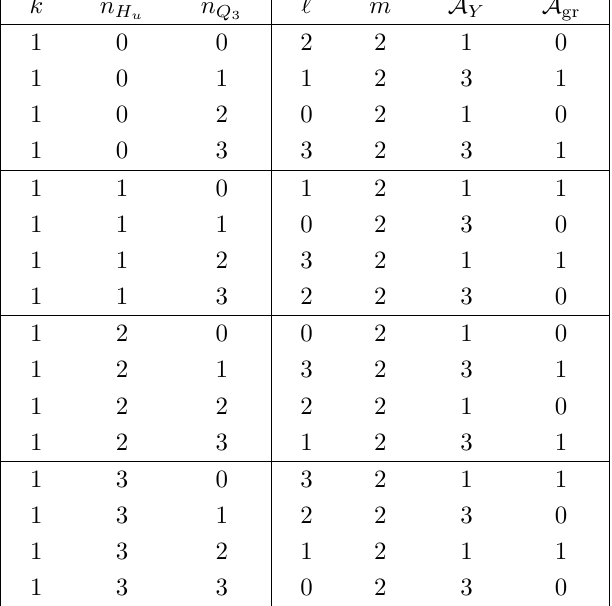
Table 2 . The same (cid:12)gure as table 1, but k = 1 ( m = 2). If n Y is a multiple of 4, the anomalies in the U(1) Y group is absent. We (cid:12)nd ‘ = 0 and 2 for A gr (cid:17) 0 modulo